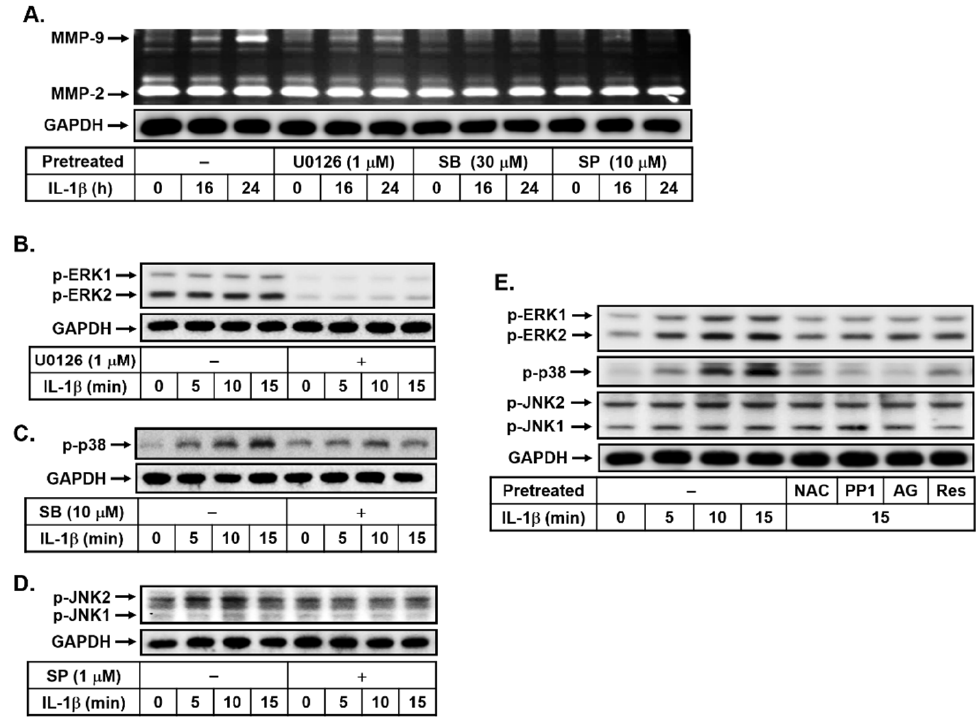
Figure 4. Resveratrol attenuates IL-1 β -induced MMP-9 expression through repressing MAPK-dependent manner, including ERK1/2, p38, and JNK1/2. ( A ) Cells were pretreated with U0126 (1 µ M), SB202190 (30 µ M), and SP600125 (10 µ M) for 1 h and then incubated with IL-1 β (10 ng/mL) for the indicated time intervals. ( B – D ) Cells were pretreated with ( B ) 1 µ M U0126, ( C ) 30 µ M SB202190 (SB), and ( D ) 10 µ M SP600125 (SP) for 1 h and then incubated with IL-1 β (10 ng/mL) for the indicated time intervals. ( E ) Cells were pretreated with NAC (10 mM), PP1 (1 µ M), AG (30 µ M), and Res (1 µ M) for 1 h before exposure to IL-1 β (10 ng/mL) for the indicated times. The conditioned media were collected and analyzed as described in Figure 1A. The cell lysates were analyzed for the phosphorylation of ( B , E ) ERK1/2 (p-ERK1/2), ( C , E ) p38 MAPK (p-p38), ( D , E ) JNK1/2 (p-JNK1/2), and ( A – E ) GAPDH by Western blot, as described in Methods. The image represents one of three individual